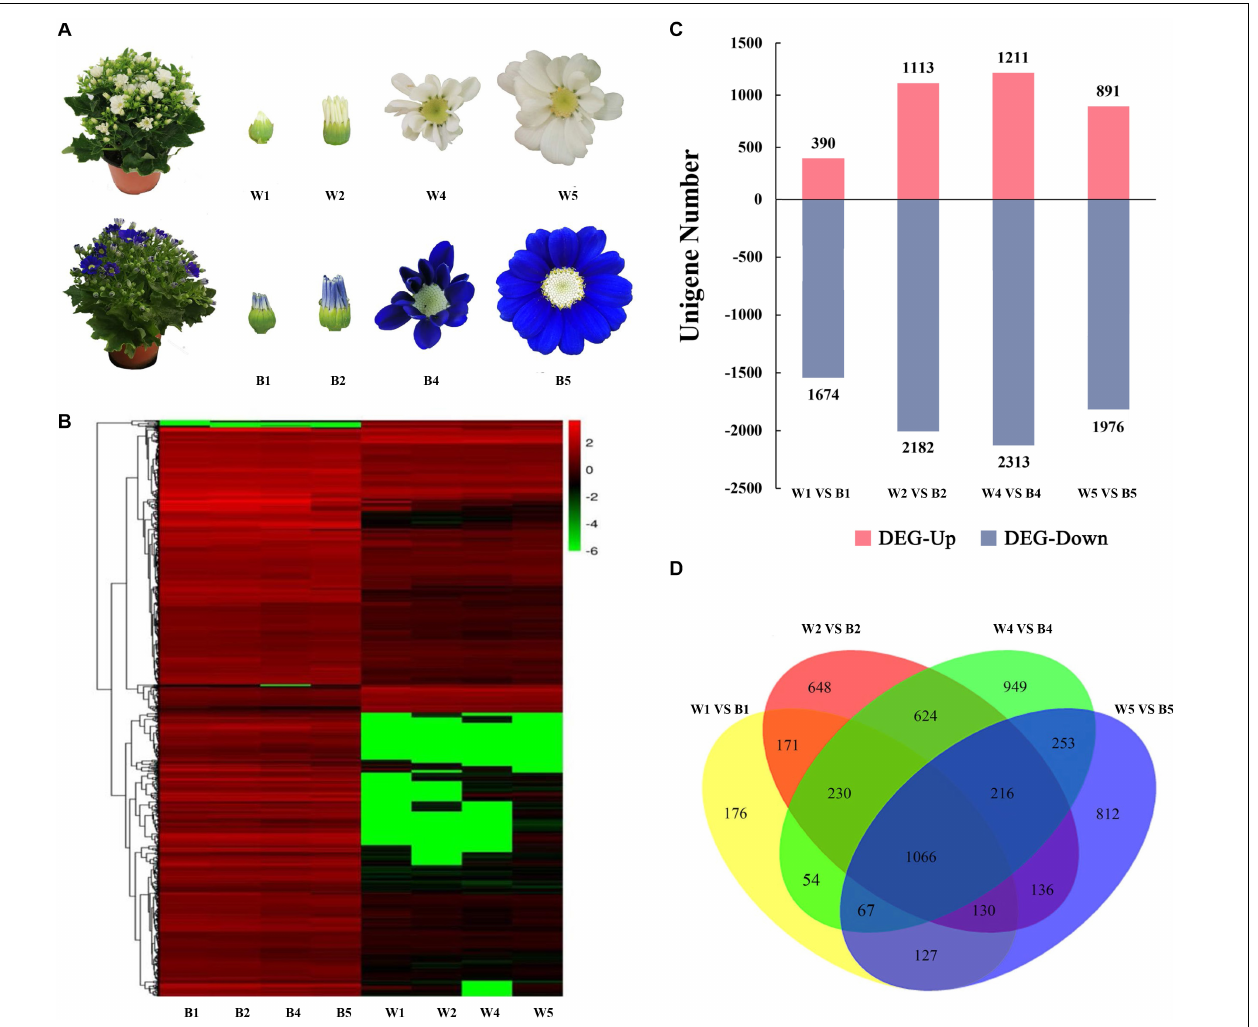
FIGURE 3 | Comparative transcriptomics analysis between the ray florets of VeB and VeW. (A) The ray florets of VeW and VeB at the S1, S2, S4, and S5 stages (renamed W1, W2, W4, W5 and B1, B2, B4, B5, respectively) were used for second-generation sequencing. (B) Heatmap of all gene expression based on the second-generation sequencing data. (C) The number of up-regulated and down-regulated DEGs in comparisons among W1 vs B1, W2 vs B2, W4 vs B4, and W5 vs B5. (D) Venn diagram showing the number of DEGs through paired comparison.